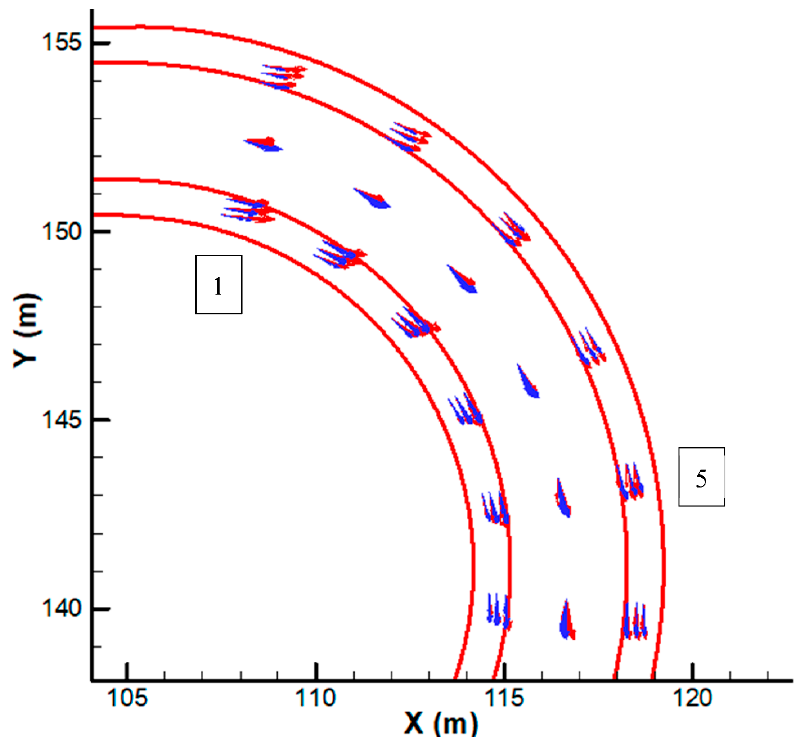
Figure A8. Plan-view comparison of simulated (blue) and measured (red) velocity vectors for the entire region of the physical model.